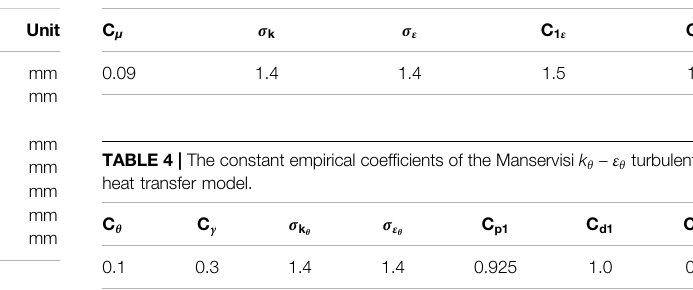
TABLE 3 | The model constants of the Abe k − ε turbulence model.